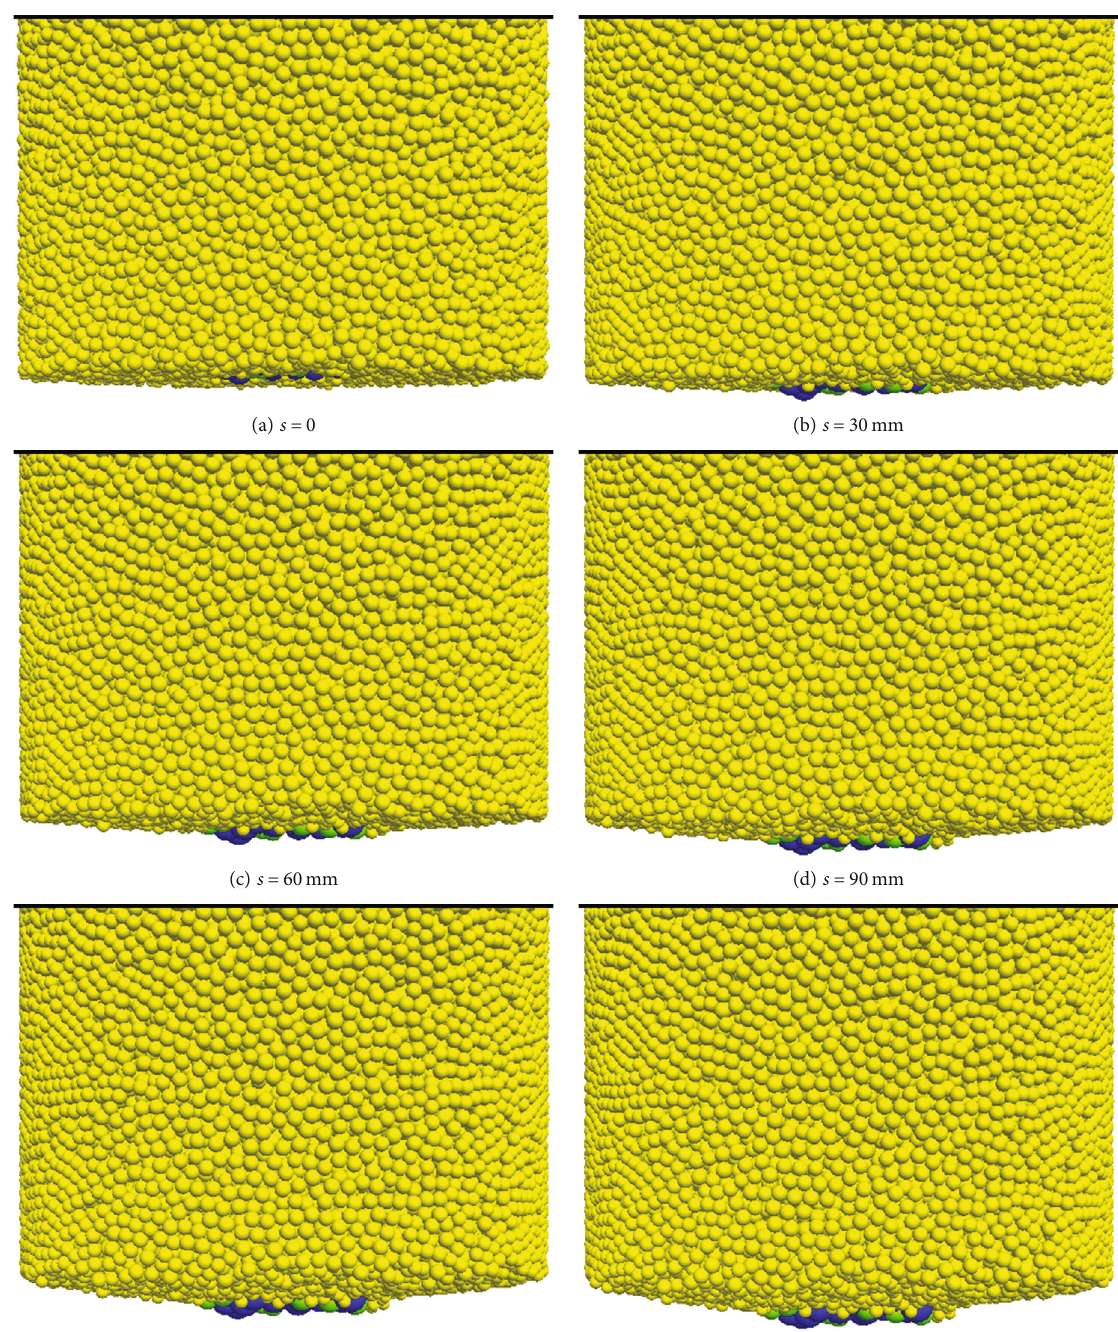
Figure 12: Deformation of column and soil at the bottom of column during